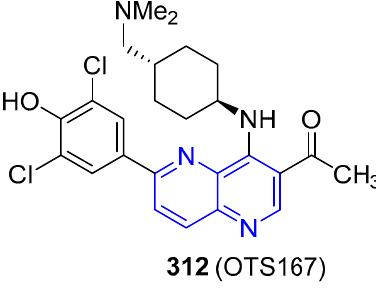
Figure 32. A human β -cell replication-promoter.